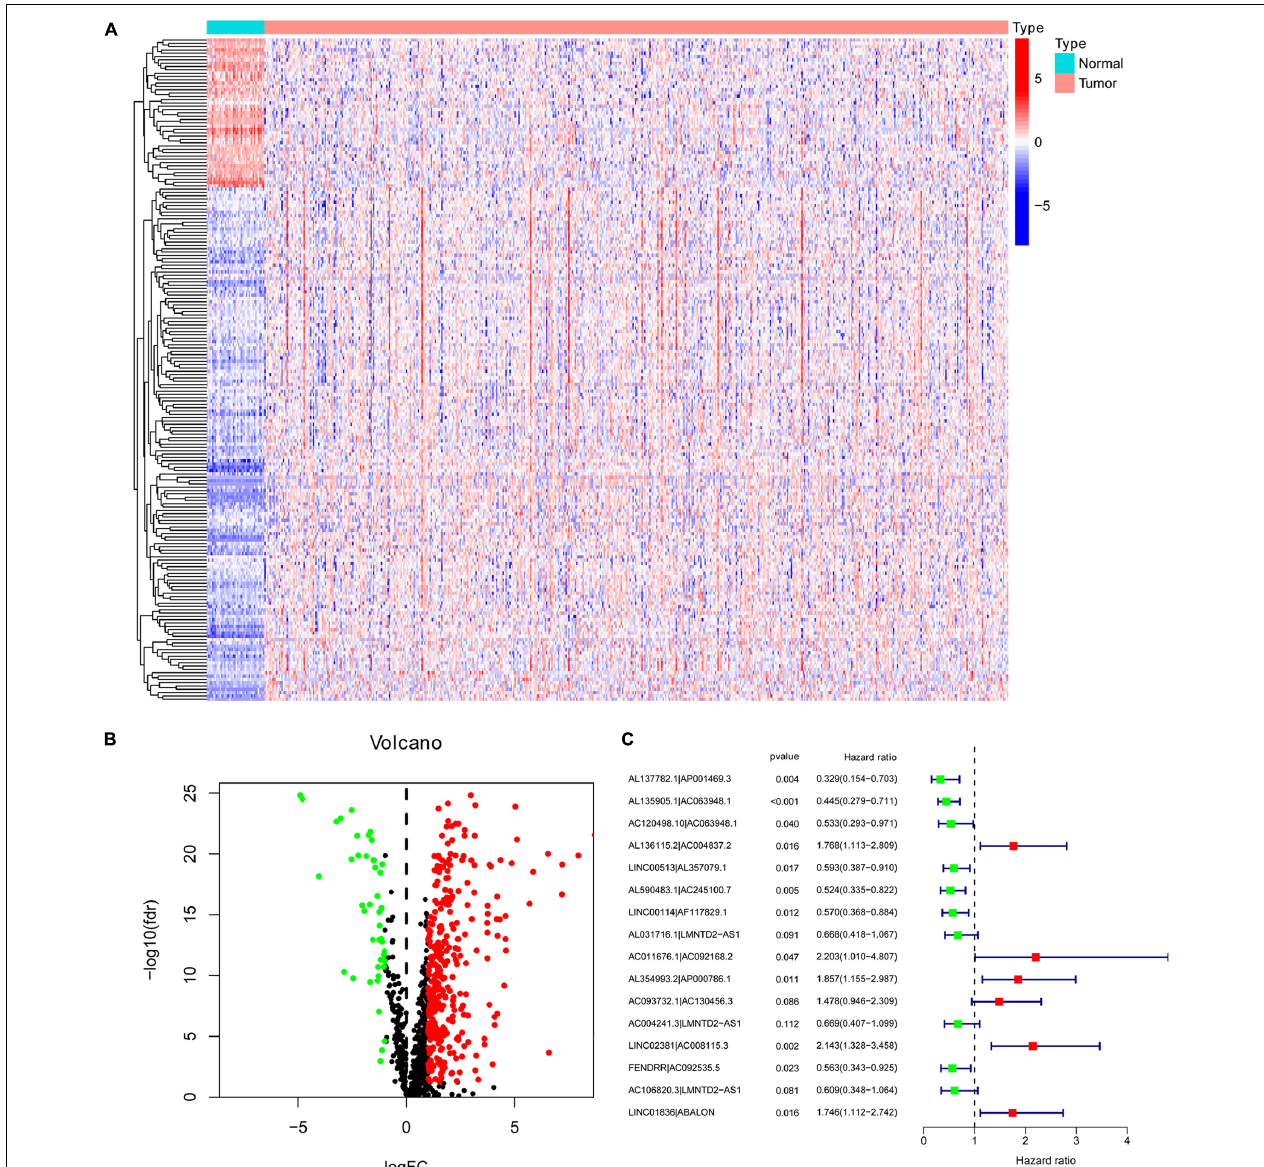
FIGURE 1 | Identification of differentially expressed immune-related LncRNA (DEirlncRNA) and the construction of a signature. The expression information of DEirlncRNA was displayed in the heatmap (A) and volcano plot (B) . (C) A forest map showed 16 DEirlncRNA pairs included in the